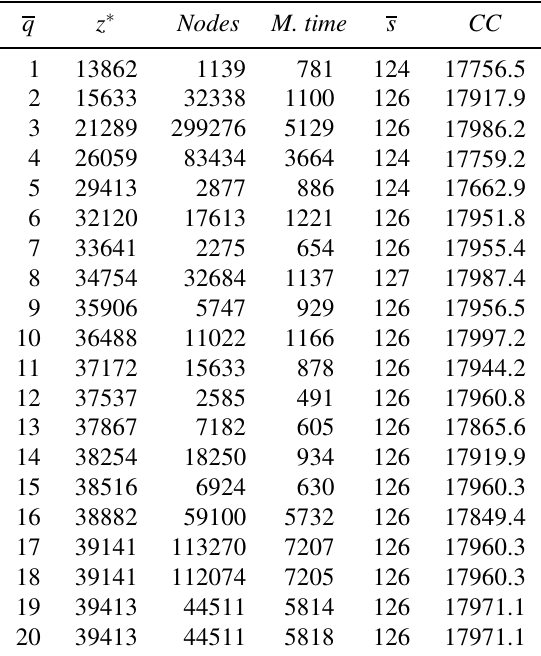
Table 8. Computational results for C